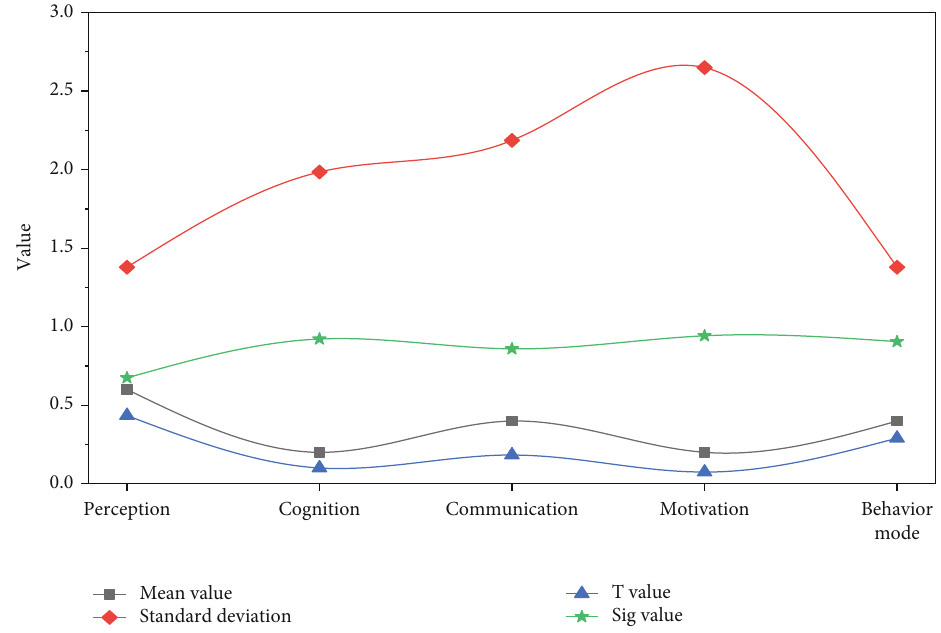
Figure 5: Comparison of pretest di ff erences of SRS scale between the experimental group and control